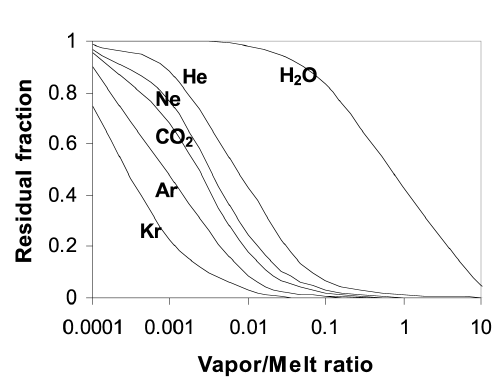
Fig. 12. Fraction of noble gases remaining in a tholeiitic melt with respect to the amount of exsolved vapor during a closed system degassing. Vapor/melt ratio is the volume of gas phase exsolved per volume unit of melt. Adopted equations for calculations were those by Giggenbach (1996), as well as the H 2 O and CO 2 solubilities. CO 2 solubility causes CO 2 to degas before light noble gases, whereas H 2 O is much more soluble and is exsolved during late